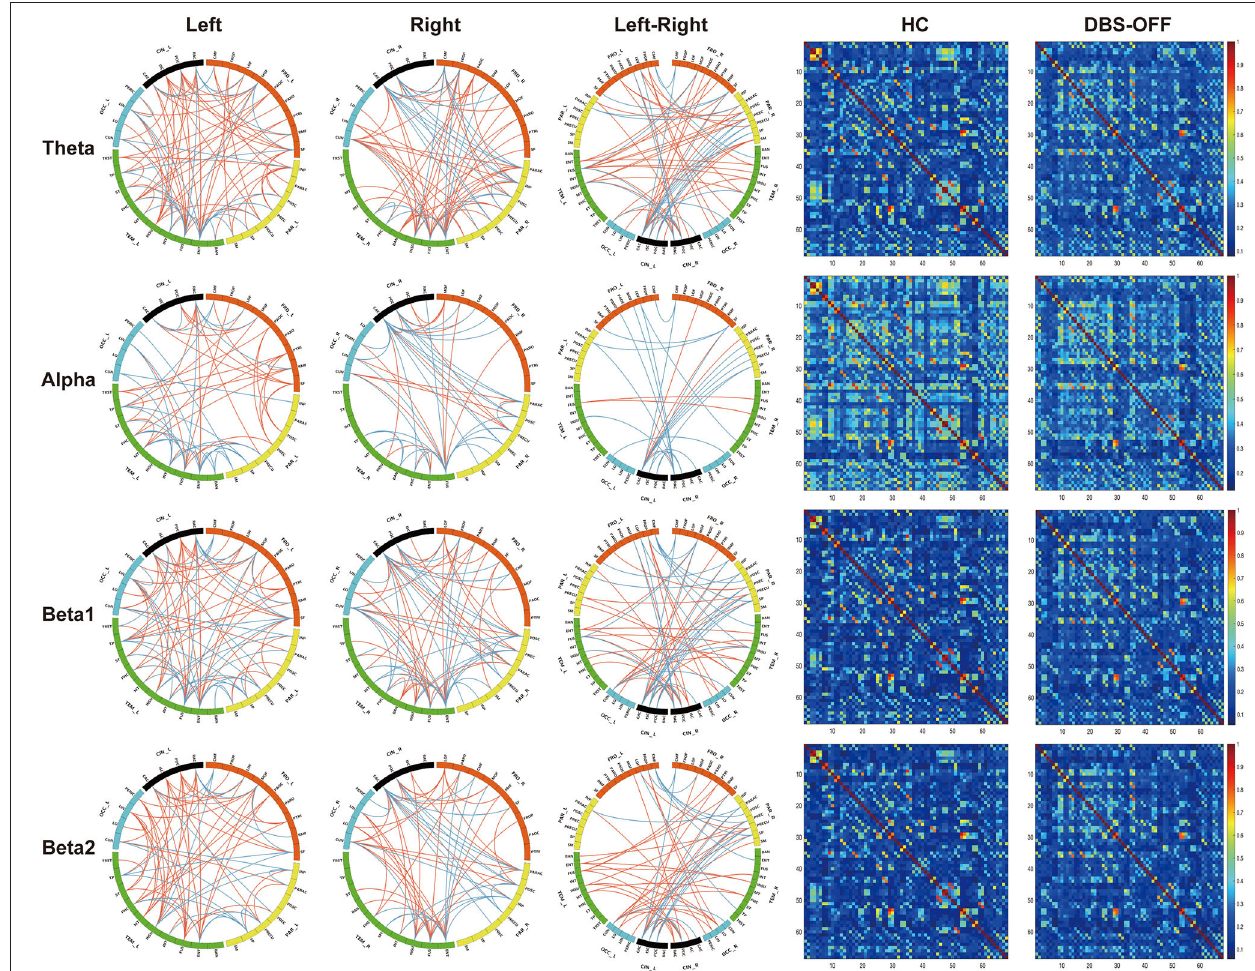
FIGURE 3 | Edgewise significant difference between healthy control and patients with PD in DBS-OFF: the left three columns of circular graphs show significant group differences across groups. The “Left” column shows significant group differences of functional connectivity within the left hemisphere at given frequency bands. The “Right” column shows significant group differences of functional connectivity within the right hemisphere at given frequency bands. The “Left-Right” column shows significant group differences of functional connectivity between the hemispheres at given frequency bands. The orange lines indicate increased functional connectivity, and the blue lines indicate decreased functional connectivity. The right two columns of matrixes indicate the functional connectivity of the group average at given frequency